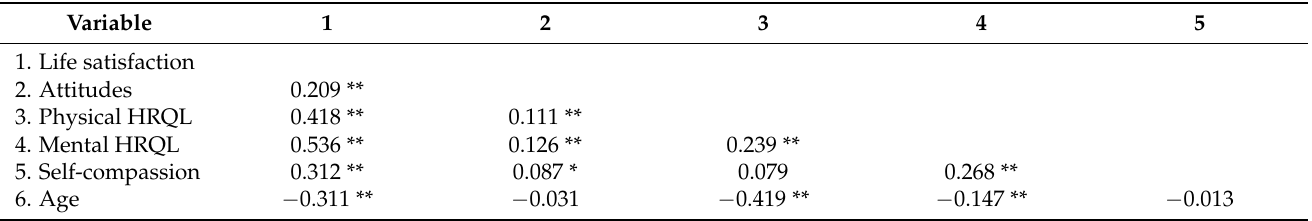
Table 2. Pearson Product–Moment correlations between dependent and independent variables.